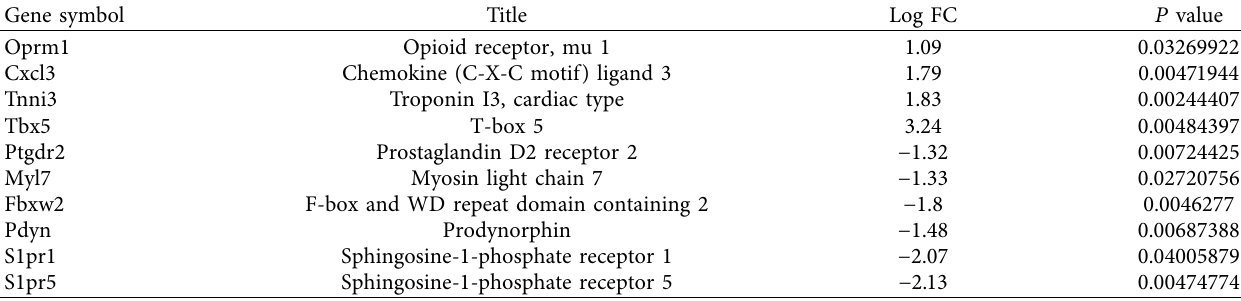
Table 1: The information of 10 hub gene.